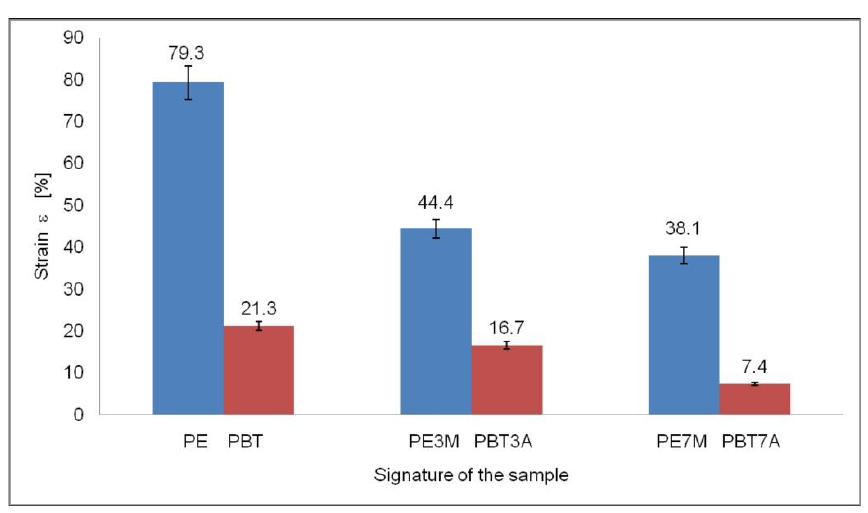
Figure 6. Specimen strain.